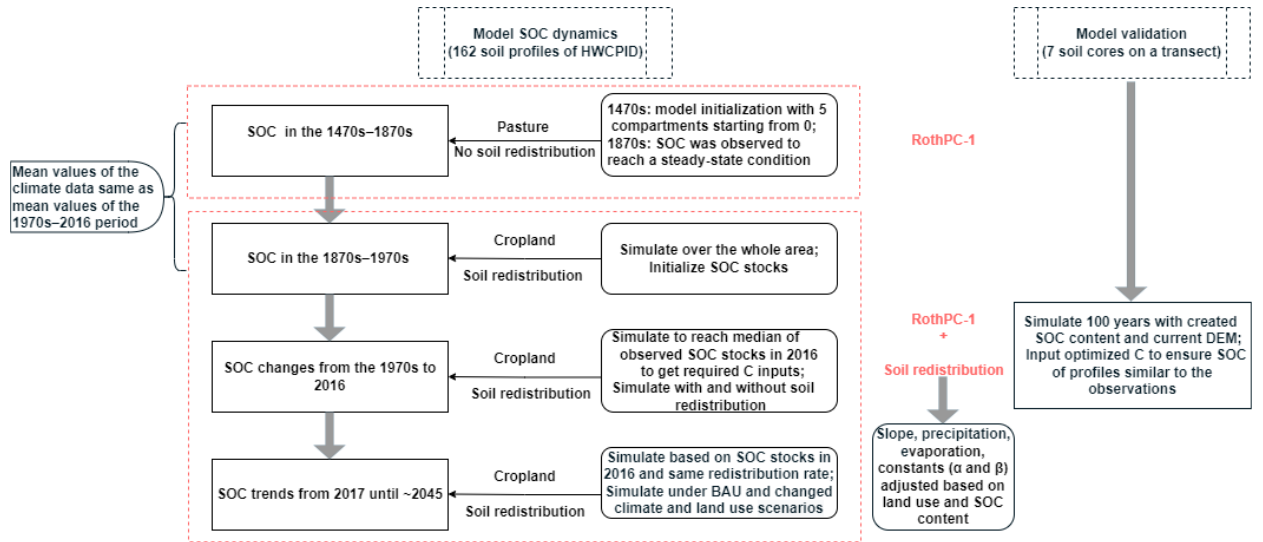
Figure 4. The flowchart for model simulation and model validation.